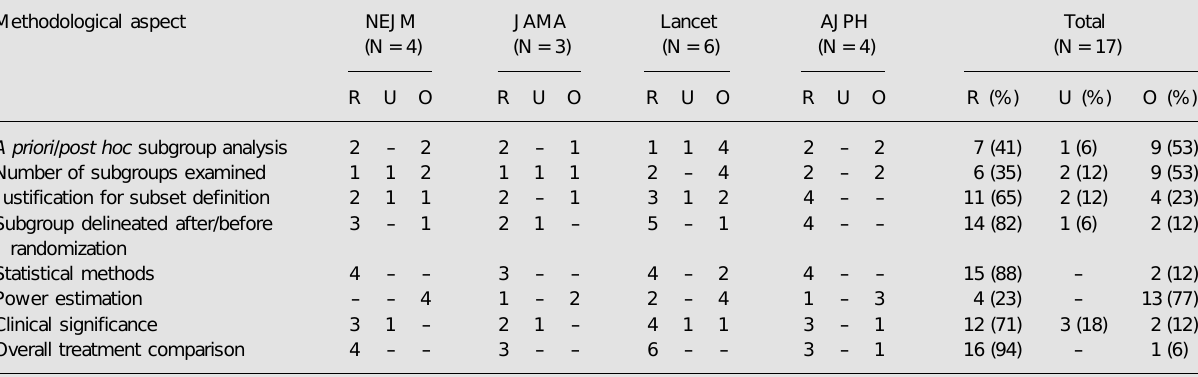
Table 2. Frequency of reporting eight important aspects for planning and interpreting the results of subgroup analysis in randomized clinical trials in four scientific journals.